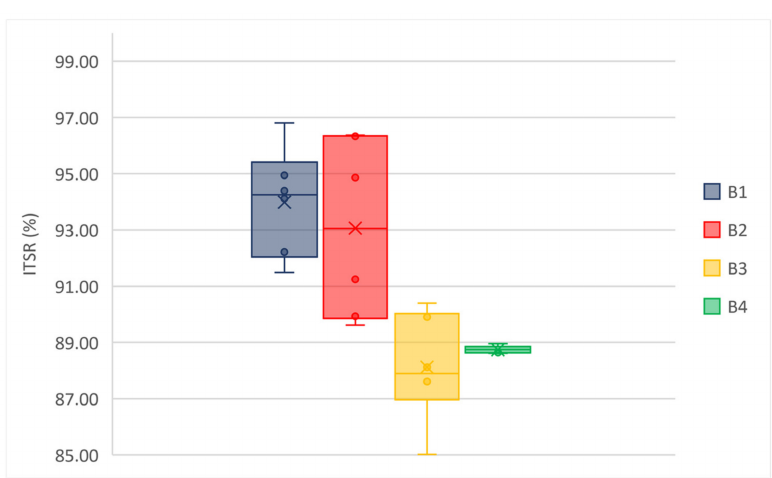
Figure 8. ITSR of wearing mixtures.